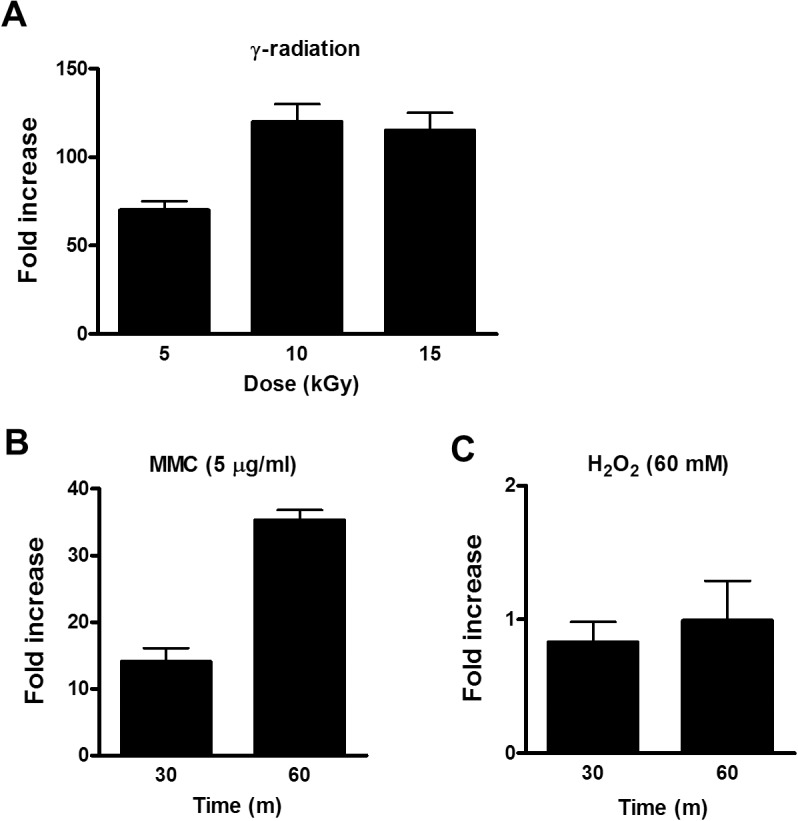
Expression profiles of dr0053 after γ-radiation, MMC, and H2O2.
D. radiodurans R1 cultures were exposed to γ-radiation (A), MMC (B), and H2O2 (C) at the indicated conditions and were allowed to recover for 1 h. After total RNA isolation, qRT-PCR analysis was performed to determine dr0053 transcript levels. The fold increase was obtained by dividing dr0053 expression levels in the treated cells by those from the non-treated cells. Error bars indicate the standard deviations from three independent experiments conducted in duplicate.